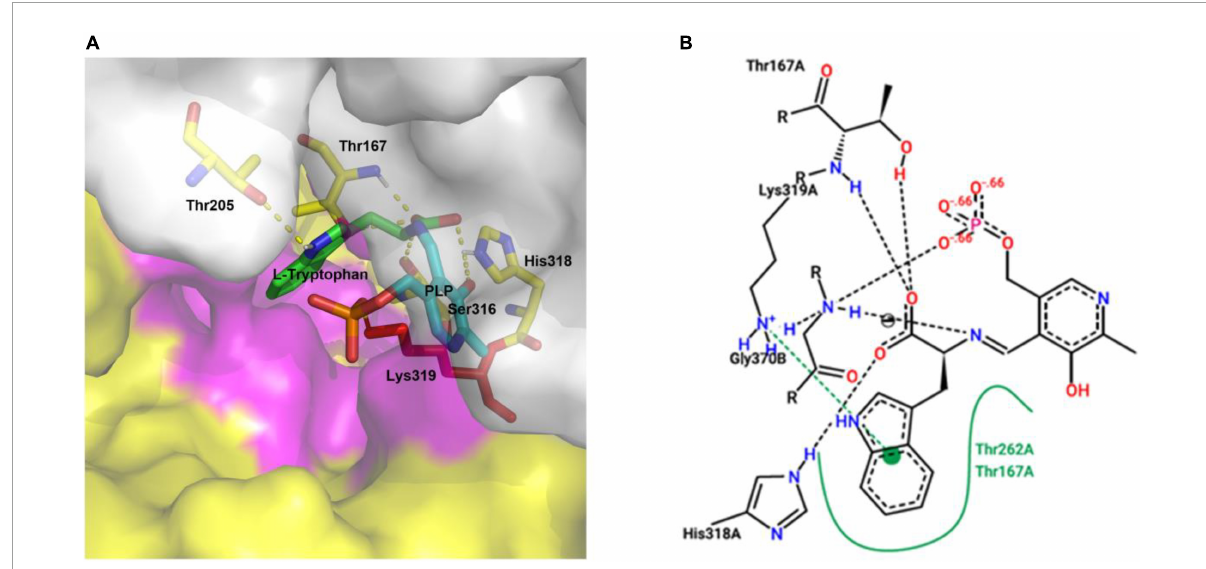
FIGURE6 Molecular docking of CaTDC3 with L-tryptophan (A) and its concise diagram (B) . The catalytically active pocket of CaTDC3 was composed of two monomers, one in yellow and another in light gray, respectively. The amino acid residues Thr167, Thr205, Ser316, His318, and Lys319 were highlighted. The other amino acid residues within 5 angstrom around L-tryptophan were shown in purple. L-Tryptophan, PLP, and the key catalytic amino acid Lys319 were presented in green, cyan, and red, respectively. The binding energy was calculated to be –5.91 kcal/mol.